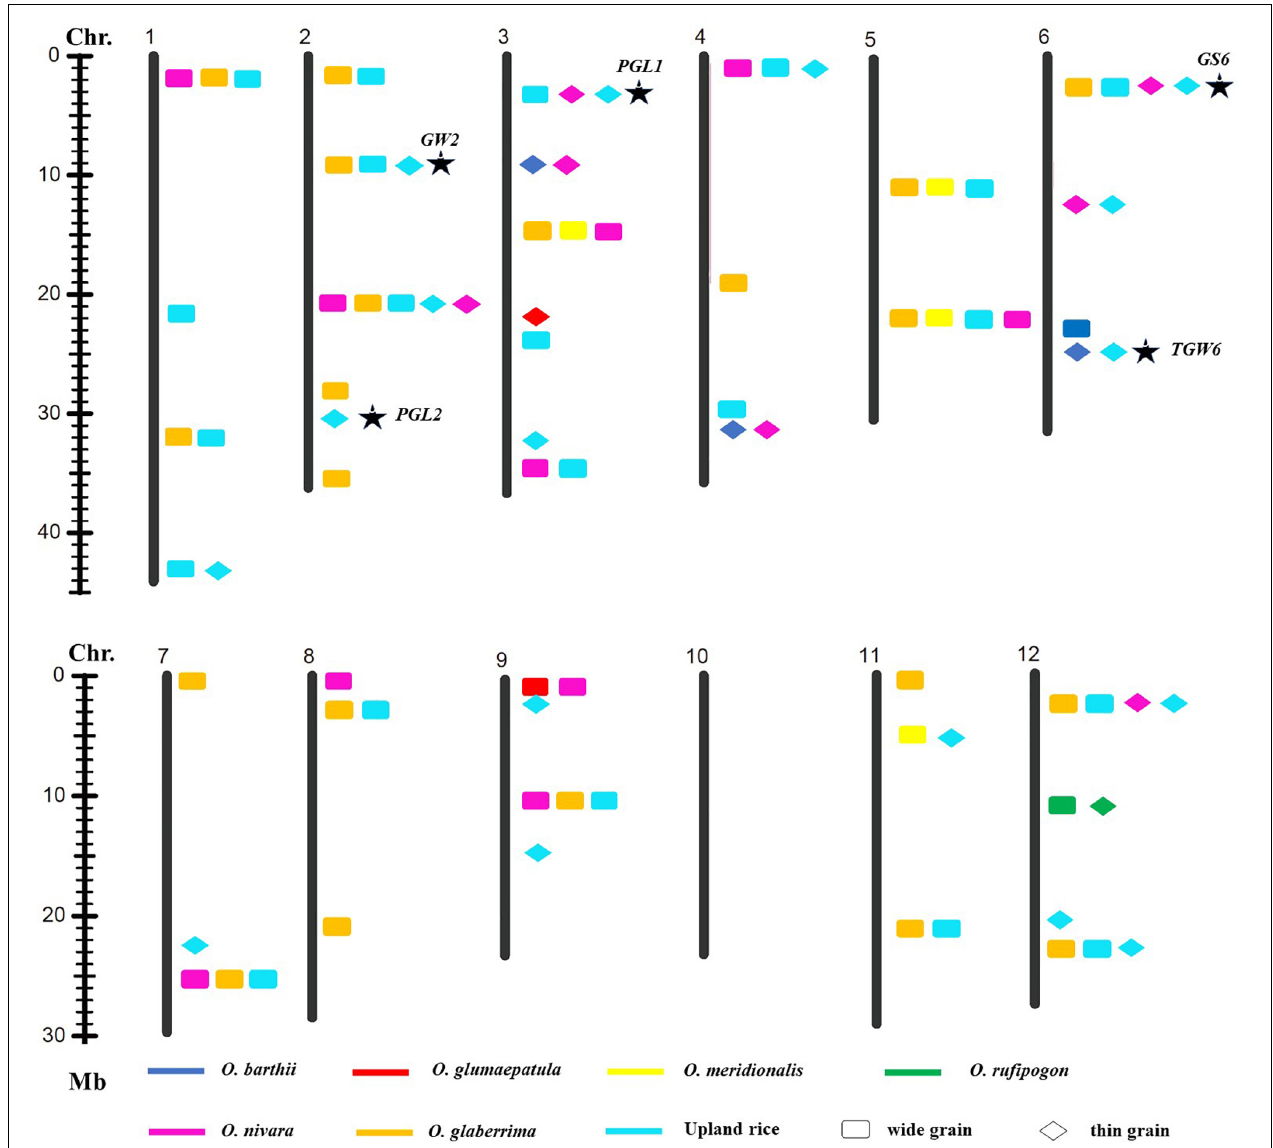
FIGURE 4 | Allelic variation linking with GW was detected from the different donors. Asterisk indicated published